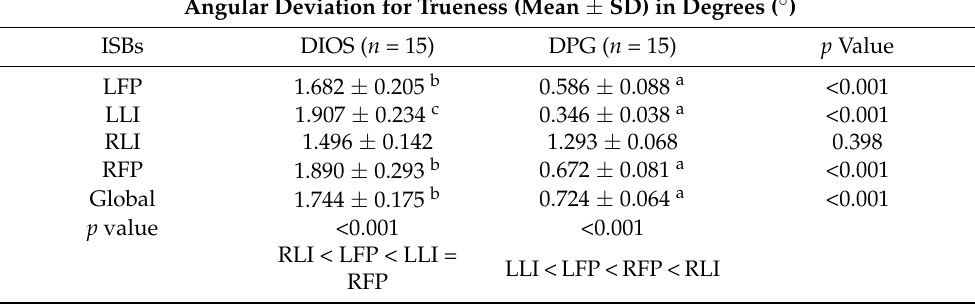
Table 1. Means and standards deviations of angular distortions among implant level impression techniques in terms of